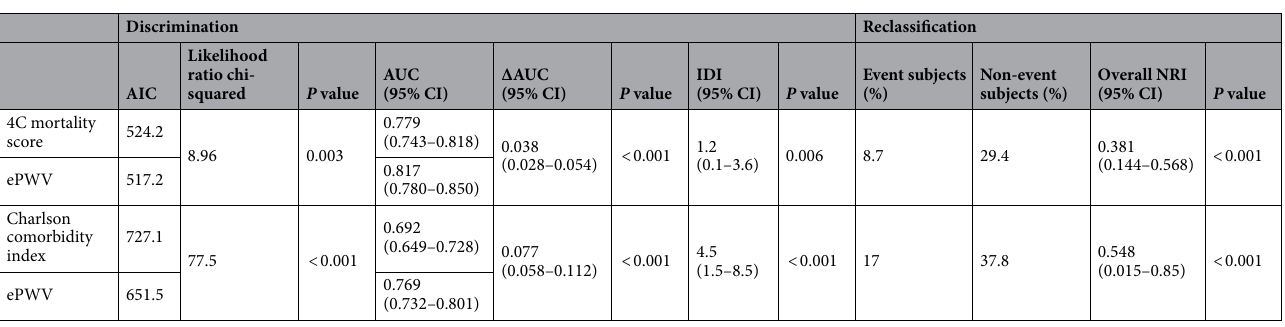
Table 3. Additive calibration, discrimination, and reclassification value of ePWV on 4C mortality score for predicting 28-day mortality (n = 626). 95% CI are derived from bootstrapping with 1,000 replicates. 4C, Coronavirus Clinical Characterisation Consortium; ePWV, estimated pulse wave velocity; AIC, Akaike information criterion; AUC, area under the curve; NRI, net reclassification index; ΔAUC, difference in AUC; IDI, integrative discrimination index; NRI, net reclassification